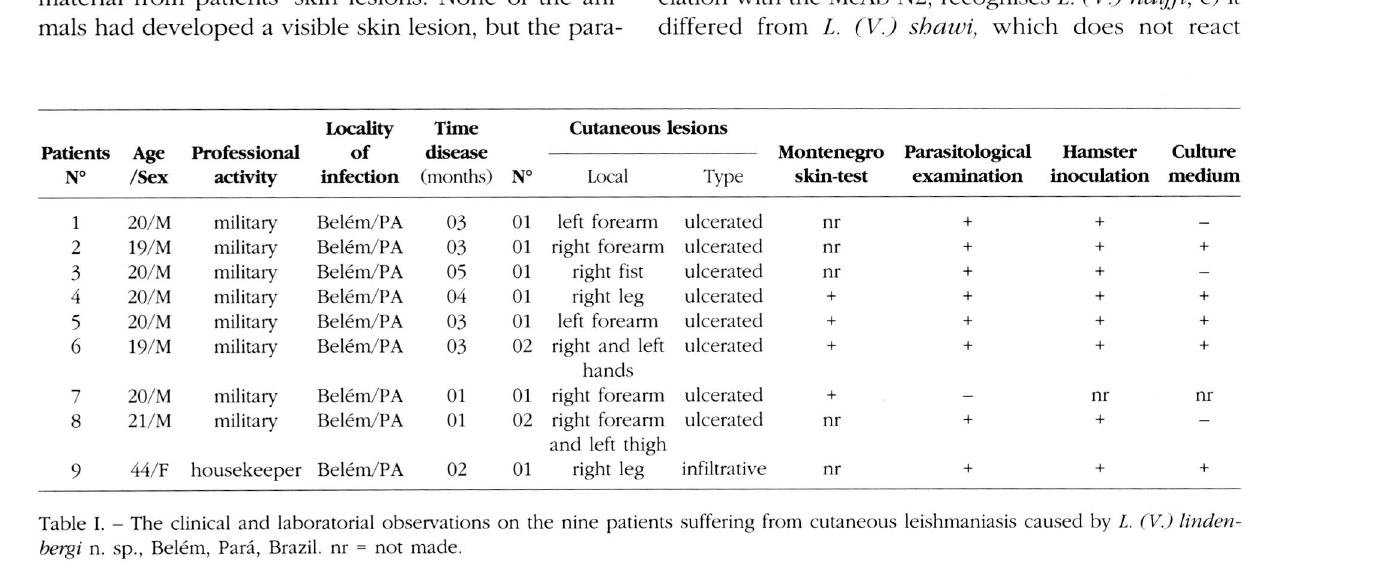
Parasite, 2002, 9,